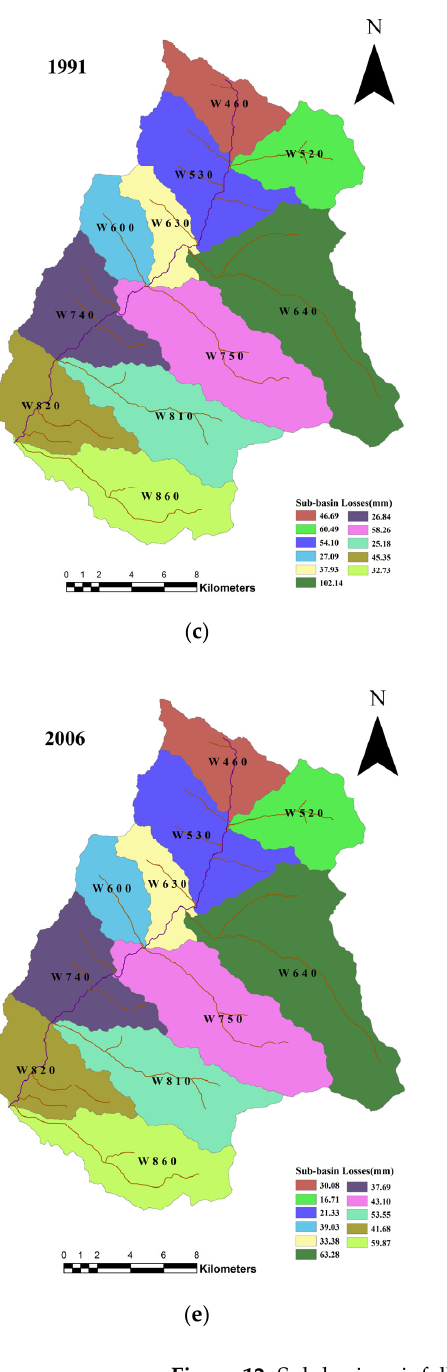
Figure 12. Sub-basin rainfall losses of the study Figure 12. Sub ‐ basin rainfall losses of the study area.